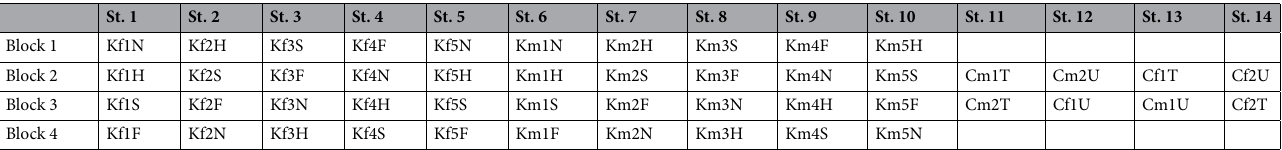
Table 3. Experimental procedure: blocks order and randomization. K = KDEF, C = CFD; f = female, m = male; N = Neutral, H = Happy, S = Sad, F = Fear, T = Trustworthy face, U = Untrustworthy face. Numbers indicate the faces’ identity. Block 1, 2, 3, and 4 were presented in order. Vice versa, the order of the stimuli within each block was totally